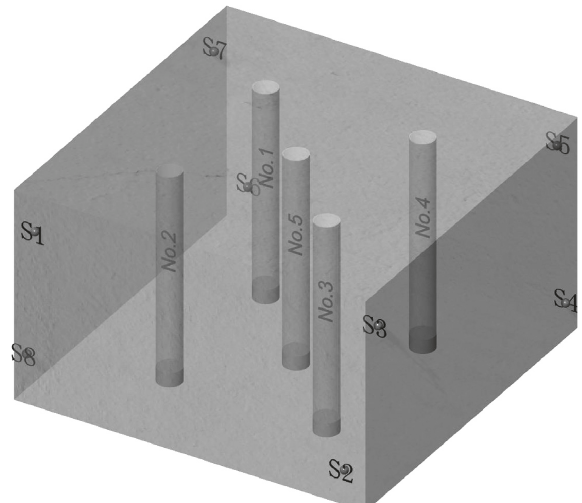
Figure 5: Schematic diagram showing the layout of the AE sensors (S1–S8).